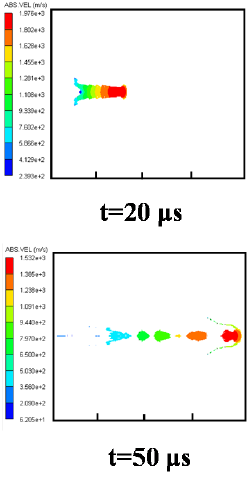
Figure 9. Velocity distribution of the EFP for Case 3.